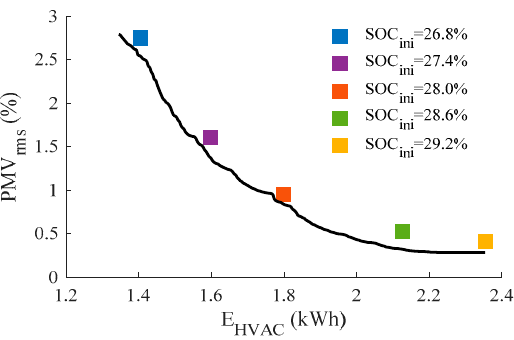
Figure 17. (cid:1842)(cid:1839)(cid:1848) (cid:3045)(cid:3040)(cid:3046) versus HVAC consumed energy for DP (black line) and the real-time algorithm Figure 17. PMV rms versus HVAC consumed energy for DP (black line) and the real-time algorithm (colored points)—Results for (cid:1846) (cid:3032)(cid:3051)(cid:3047),(cid:2868) = 37 °C , (cid:1834)(cid:1844) (cid:3032)(cid:3051)(cid:3047),(cid:2868) = 35% , (cid:1869)(cid:4662) (cid:3046)(cid:3048)(cid:3041),(cid:2868) = 500 W and the R2 driving (colored points)—Results for T ext ,0 = 37 ◦ C, HR ext ,0 = 35%,